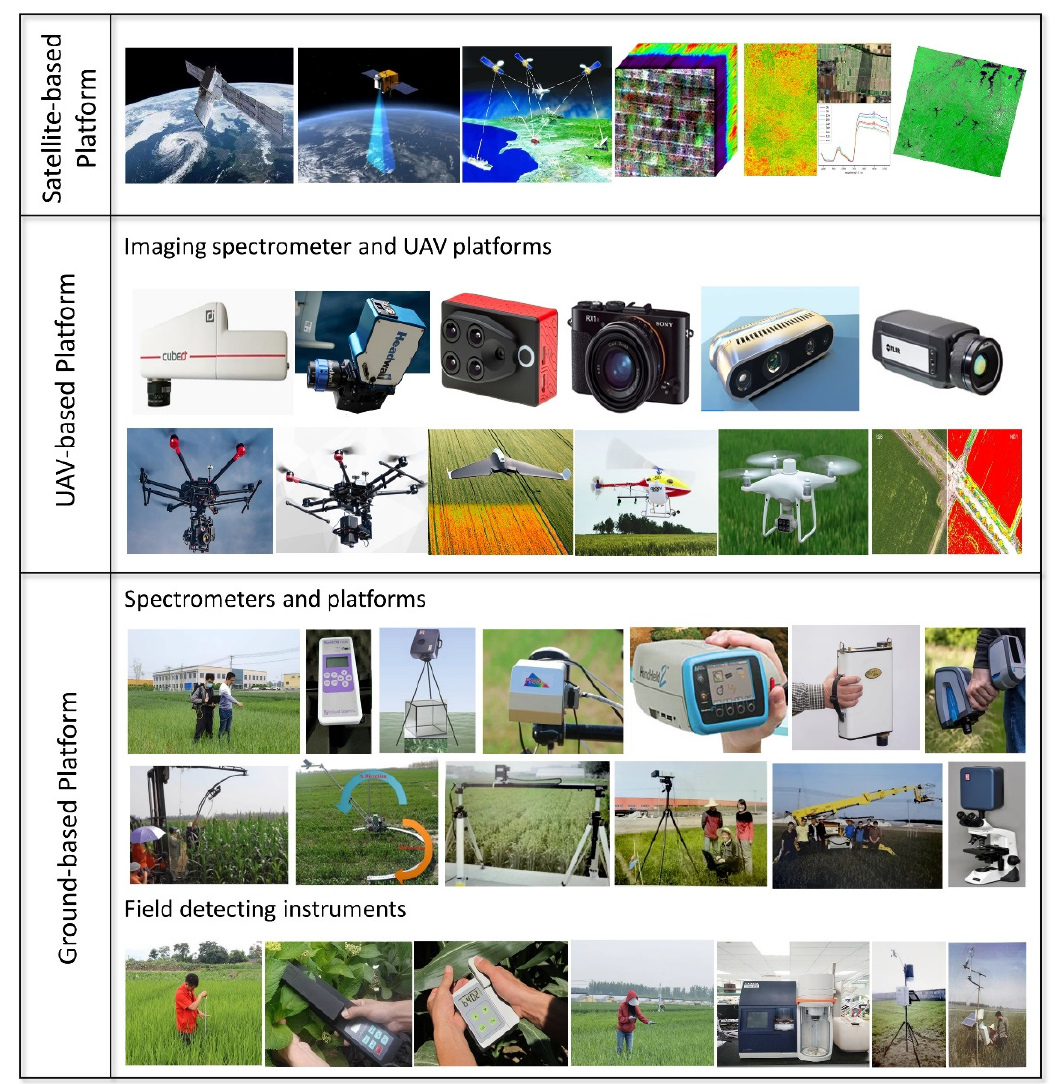
Figure 3. Remote sensing platforms, including ground-based platform, UAV-based platform, and satellite-based platform.